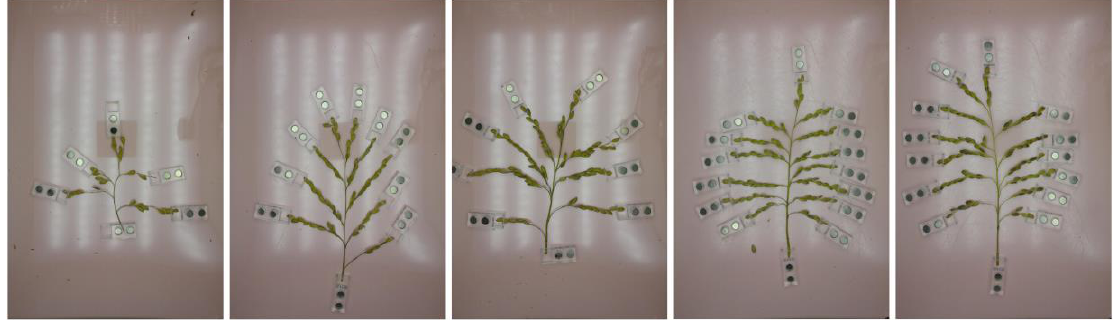
Figure 11. 5 RIL population samples 6